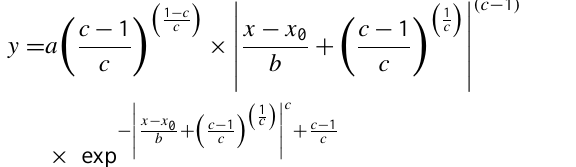
shape parameter ( c ) and the location parameter (or